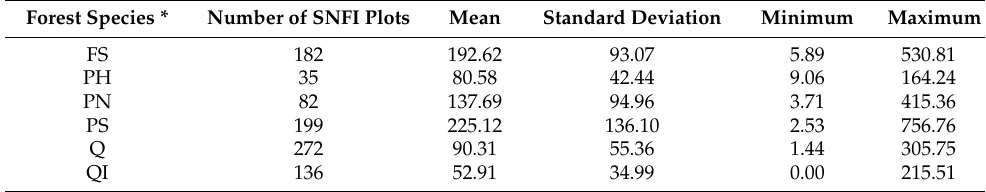
Table 1. Statistics for mean volume (m 3 / ha) obtained from the Spanish National Forest Inventory (SNFI) field plots classified as forest according to the Landsat forest species map and used for the construction of the V